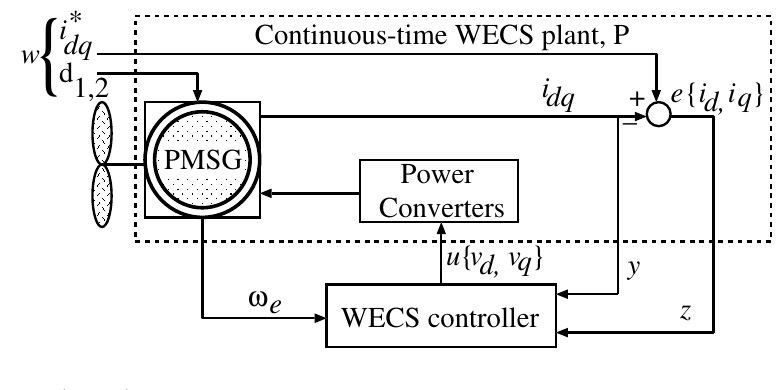
Figure 11. H control configuration for WECS. ∞